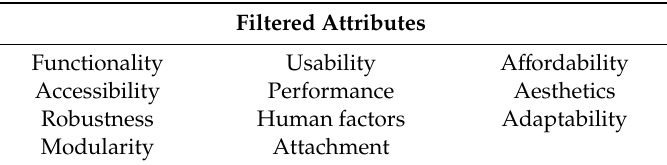
Table 1. Attributes associated to frugality.